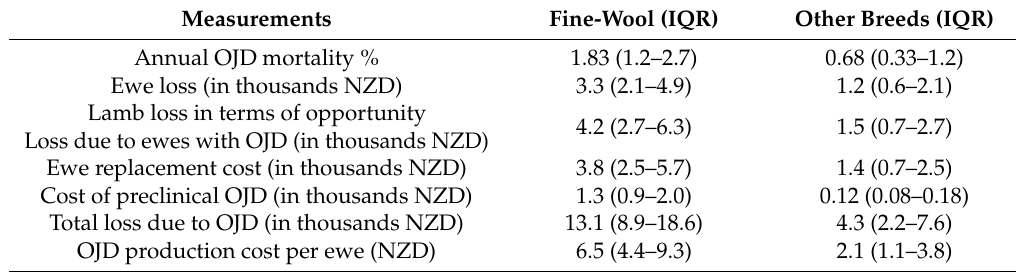
Table 5. Median (and interquartile range) annual cost of OJD for a hypothetical farm of 2000 fine-wool or other breed ewes at average annual mortality rates observed in this